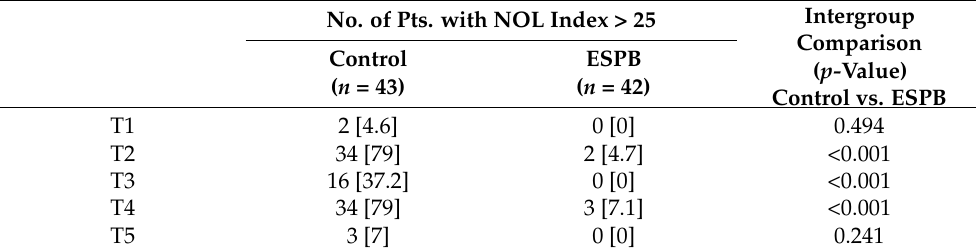
Table 3. Intergroup comparison of number of patients with nociceptive response. No. of Pts. with NOL Index > 25 Intergroup ESPBControl ( n =